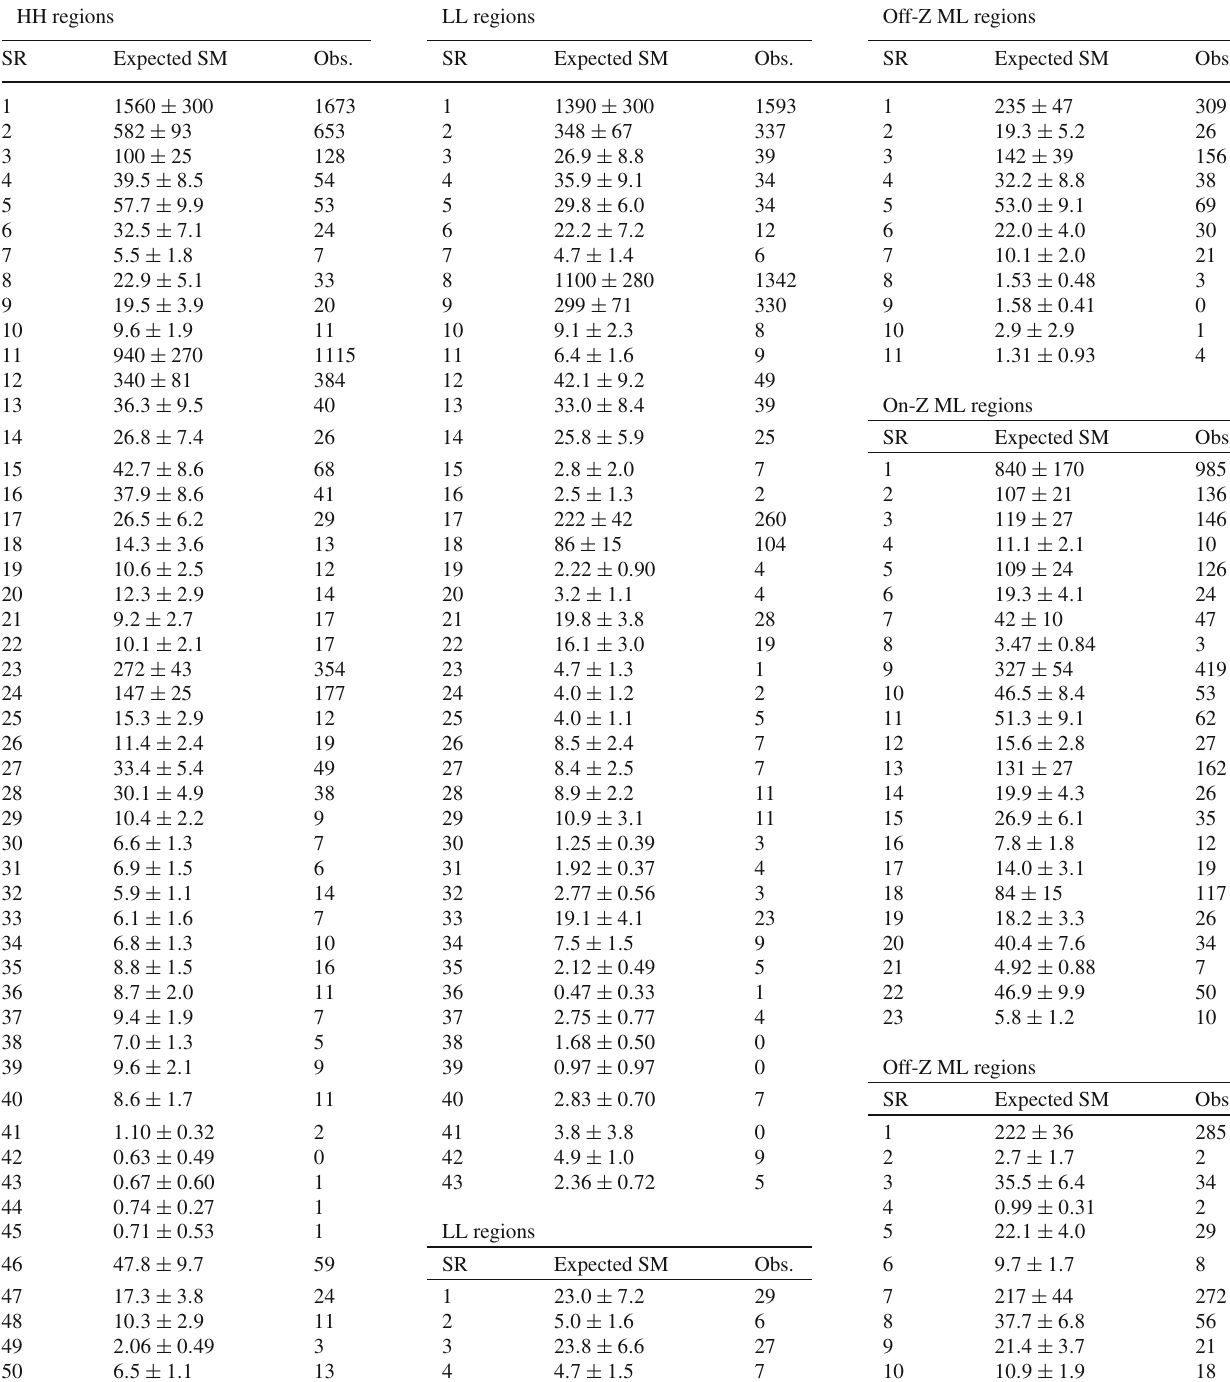
Table9 Expected background event yields, total uncertainties, and observed event yields in the SRs used in this search HH regions LL regions Off-Z ML regions